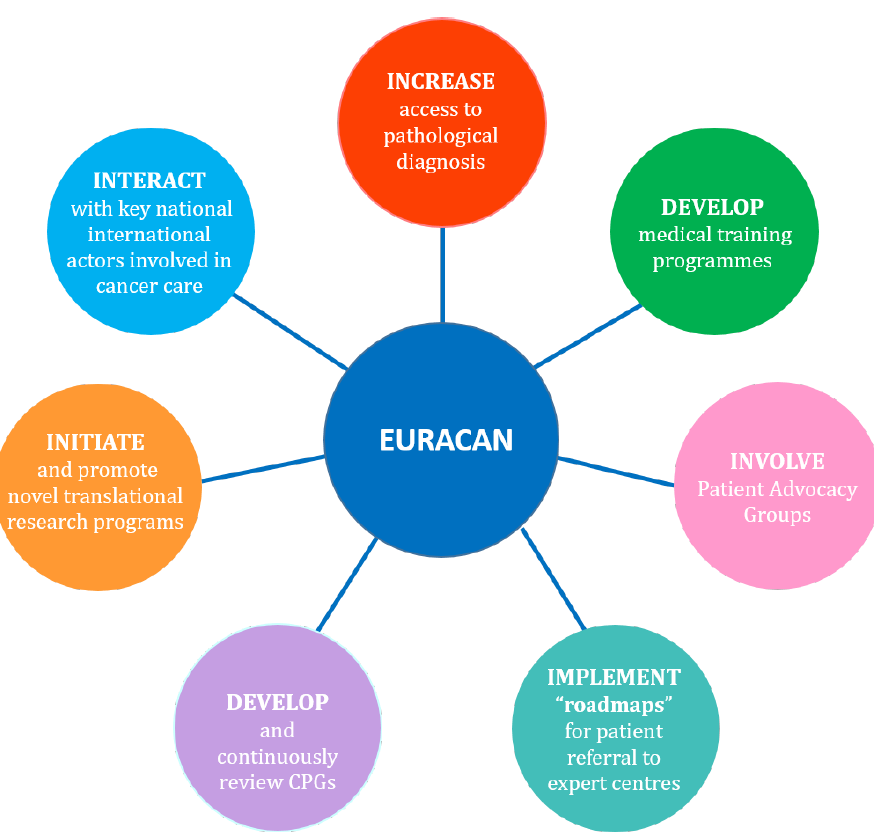
Figure 1. Objectives of the EUropean Reference Network for Rare Adult solid CAancers (ERN- Figure1. EURACAN).